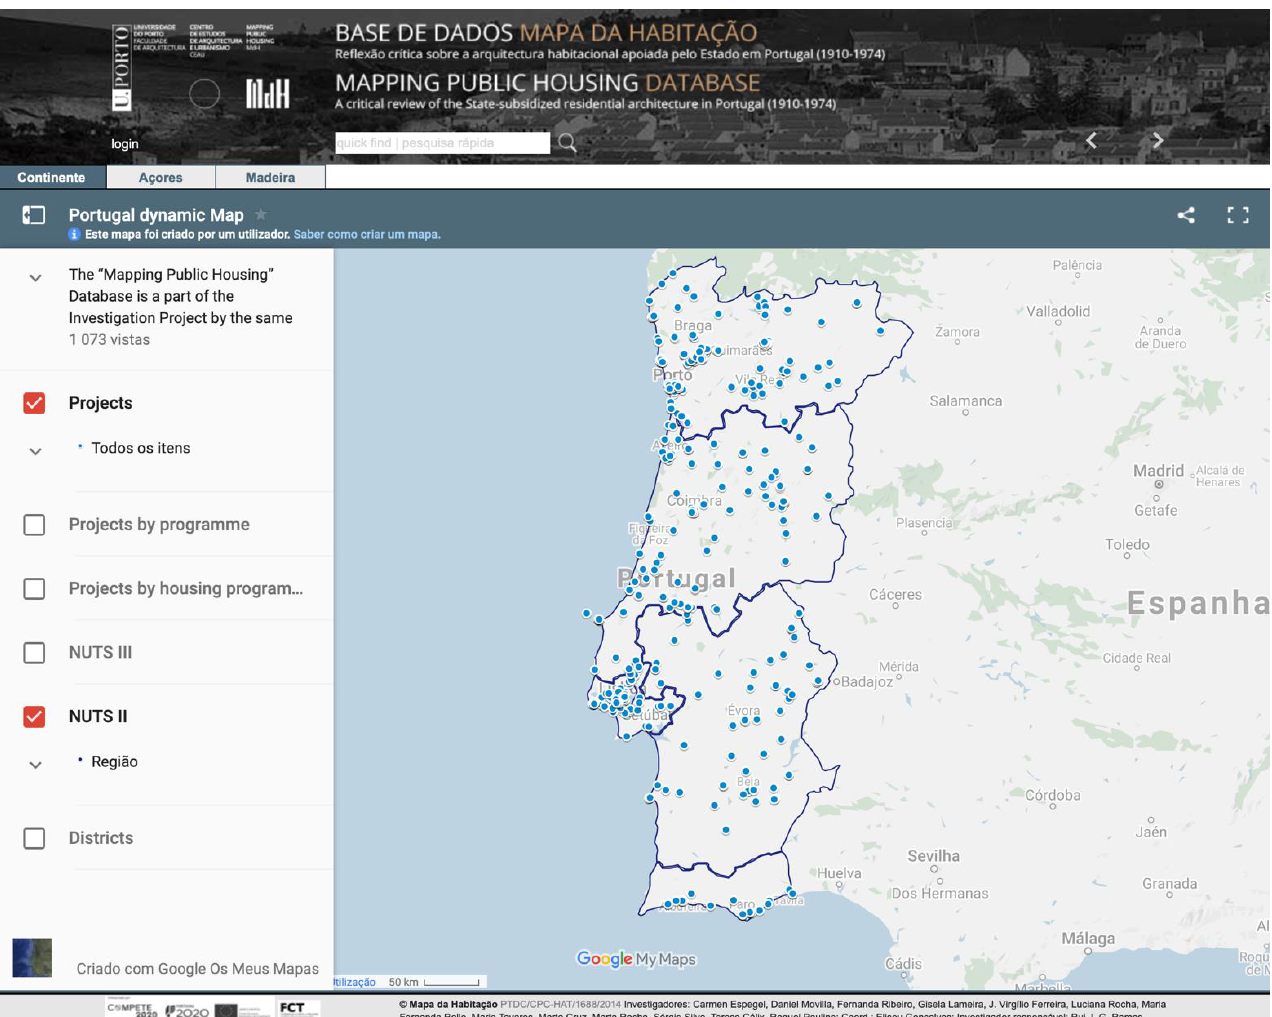
Figure A3. Map of Portugal based on NUTS II, showing the location of neighbourhoods. Source: MdH database, 2019.